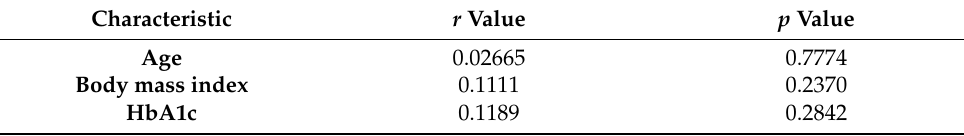
Table 3. Correlation analysis between telomere length and clinical